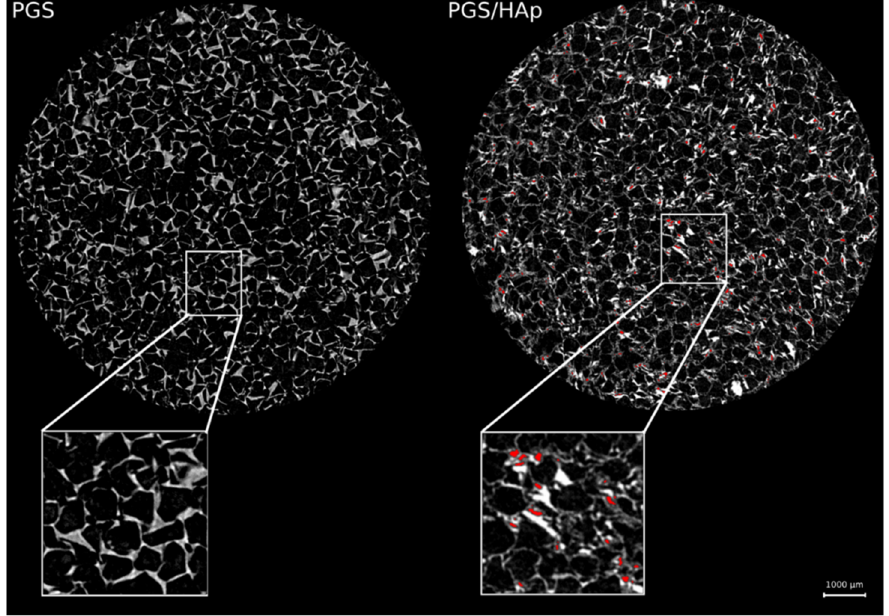
Figure 3. Representative cross-sections (µCT) of foams showing the differences in pore shape. The micropores occurring within the structure of walls are marked in red.